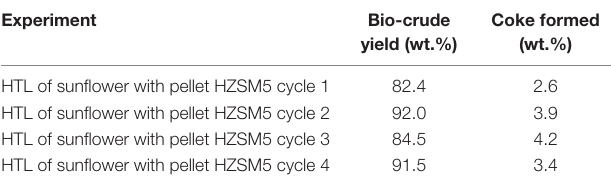
TaBle 3 | Yield (wt.%) of the hydrothermal processing of sunflower oil at 350°c for 1 h in a 77 ml bomb reactor recycling hZsM5 four times.